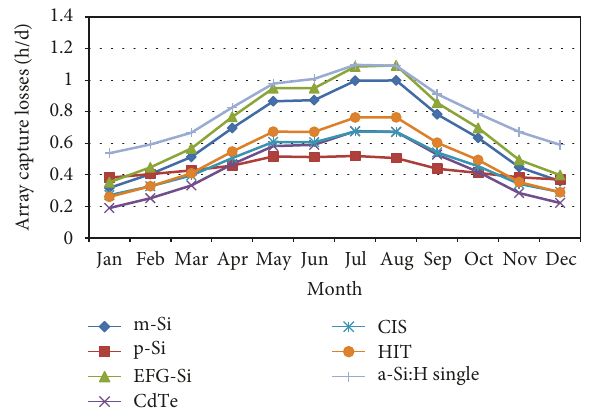
Figure 8: Monthly average array losses of seven PV module